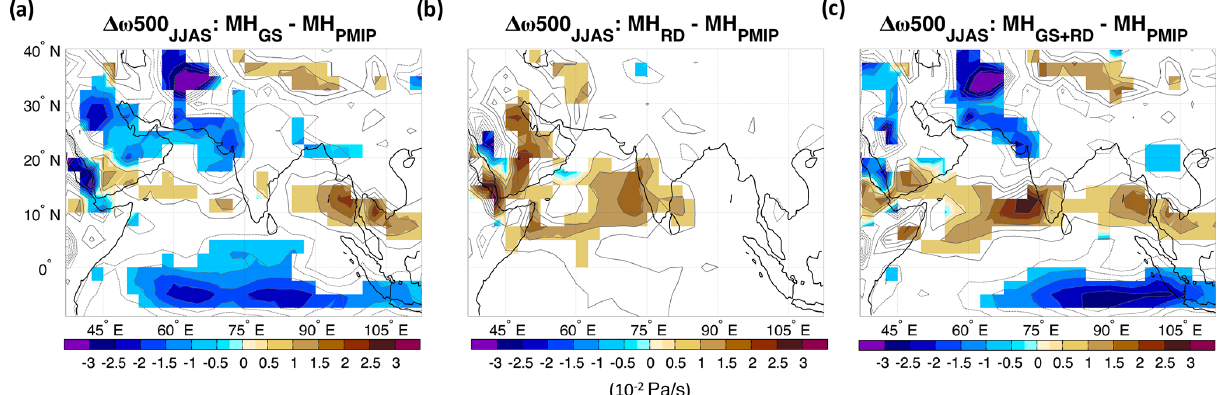
Figure A12. Changes in summer (JJAS) vertical pressure velocity at 500hPa ( ω 500; Pa/s) for (a) the mid-Holocene Green Sahara (MH GS ); (b) the dust-only reduction (MH RD ); and (c) the Sahara greening and dust reduction (MH GS + RD ) experiments relative to the mid-Holocene- only orbital forcing (MH PMIP ) simulation. The contour lines follow the color-bar scale (the 0 lines are omitted for clarity). Only differences significant at the 95% confidence level using the Student t test are